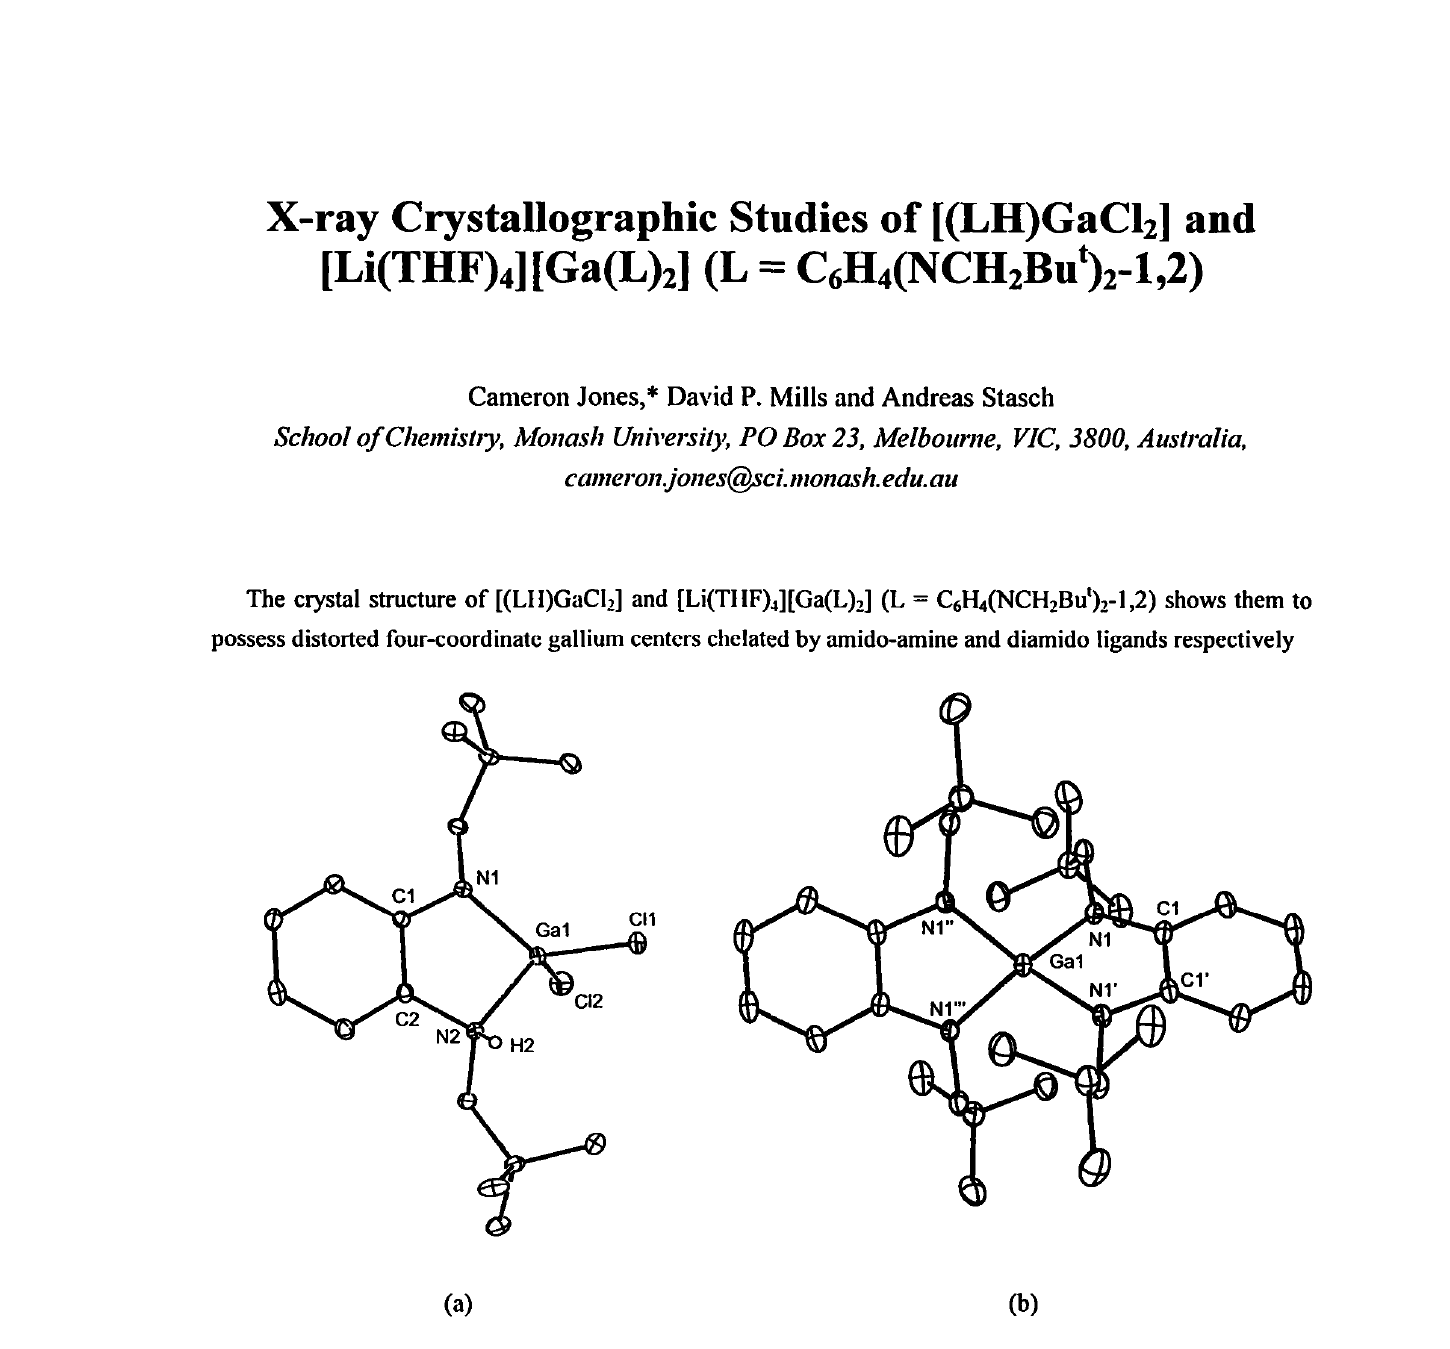
Figure 1. Structures of (a) [(LH)GaCl ] I (L = € Η (ΝΟΗ Βυ') -1,2) and (b) the anionic component of 2 6 4 2 2 [Li(THF) ][Ga(L) ] II (hydrogens, except H(2) of I, omitted for clarity, 20% ellipsoids). 4 2 Key geometric parameters (A, °): I: Ga(l)-N(l) 1.8748(16), Ga(l)-N(2) 2.0002(16), Ga(l)-Cl(2) 2.1570(9), Ga(l)-Cl(l) 2.1632(7), N(1)-C(1) 1.391(2), N(2)-C(2) 1.471(2); N(l)-Ga(l)-N(2) 89.75(7), N(l)-Ga(l)-Cl(2) 113.95(6), N(2)-Ga(l)-Cl(2) 112.30(5), N(l)-Ga(l)-Cl(l) 120.30(6), N(2)-Ga(l)-Cl(l) 107.64(5), Cl(2)- Ga(l)-Cl(l) 110.79(3). II: Ga(l)-N(l) 1.898(3), N(1)-C(1) 1.391(4), C(1)-C(1)' 1.437(7), N(l)-Ga(l)-N(l)' 87.47(16). Symmetry operations:' -x+1/2, -y+3/2, z;" x, -y+3/2, -z+3/2;'" -x+1/2, y,